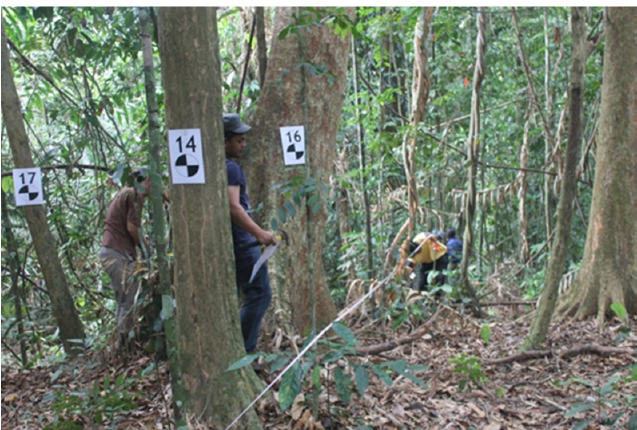
Figure 3. Individual tree measurements in a forest plot aided by a special signage located on selected